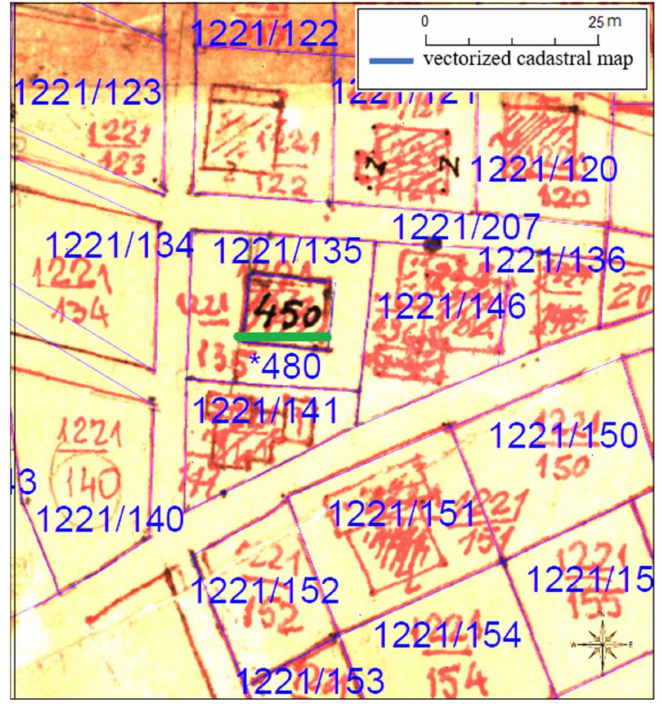
Figure 8. Example for vectorization-caused area inconsistency. Source: own compilation. the “*” represents the mark for the built-up cadastral